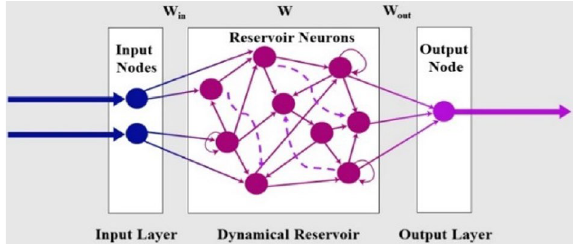
Figure 9. Echo state neural network